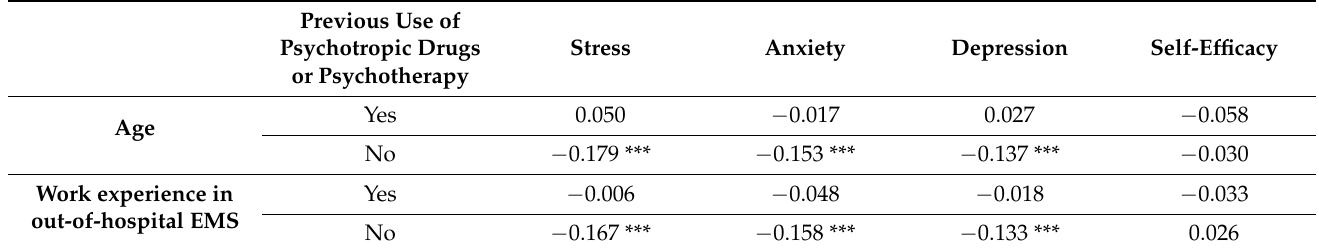
Table 7. Level of stress, anxiety, depression, and self-efficacy according to age, EMS work experience and previous use of psychotropic drugs or